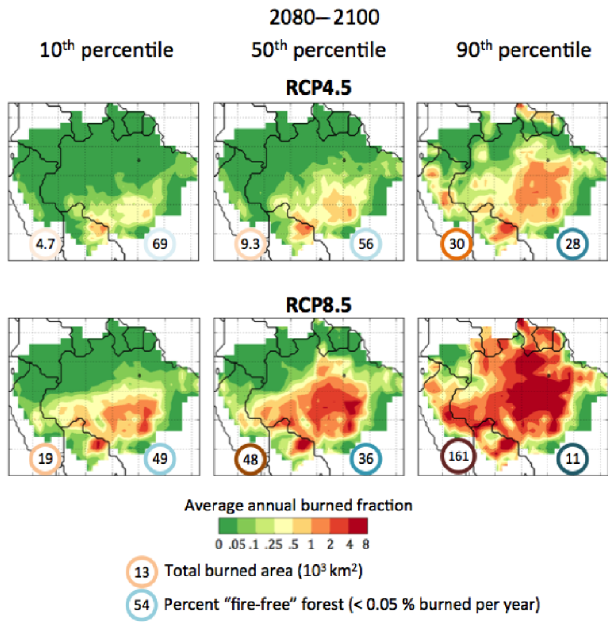
Figure 3. Annual burned fraction projected in HESFIRE for 2080– 2100 varies across models and climate scenarios. The 10th, 50th, and 90th percentile values indicate variability from eight climate models (see the “Methods”